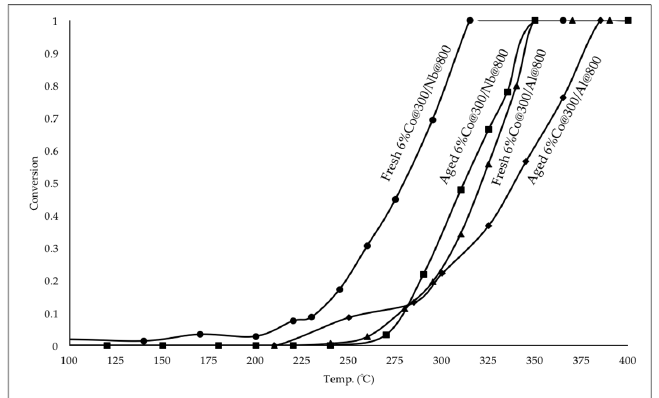
Figure 5. Fresh and aged 6% Co@300/Nb@800 and 6% Co@300/Al@800 for propane oxidation. Aging